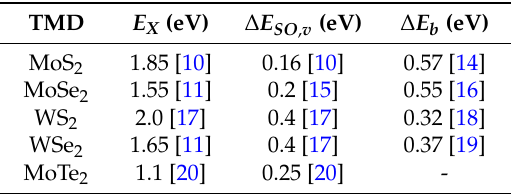
Table 1. Optical bandgap, spin orbit splitting and exciton binding energy for monolayer transition metal dichalcogenides (TMDs). TMD E X (eV) ∆ E SO , v